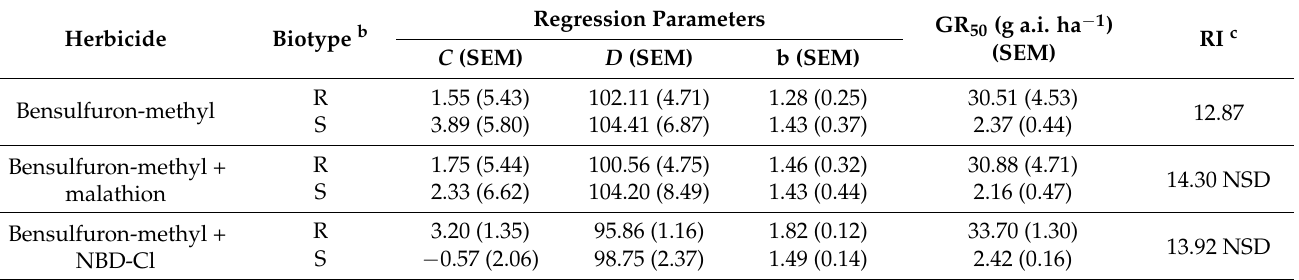
Table 4. Parameters of the log-logistic equation (1) a for the whole-plant dose-response of the cytochrome P450 inhibitor (malathion) and GST inhibitor (NBD-Cl) on C. difformis resistance to the